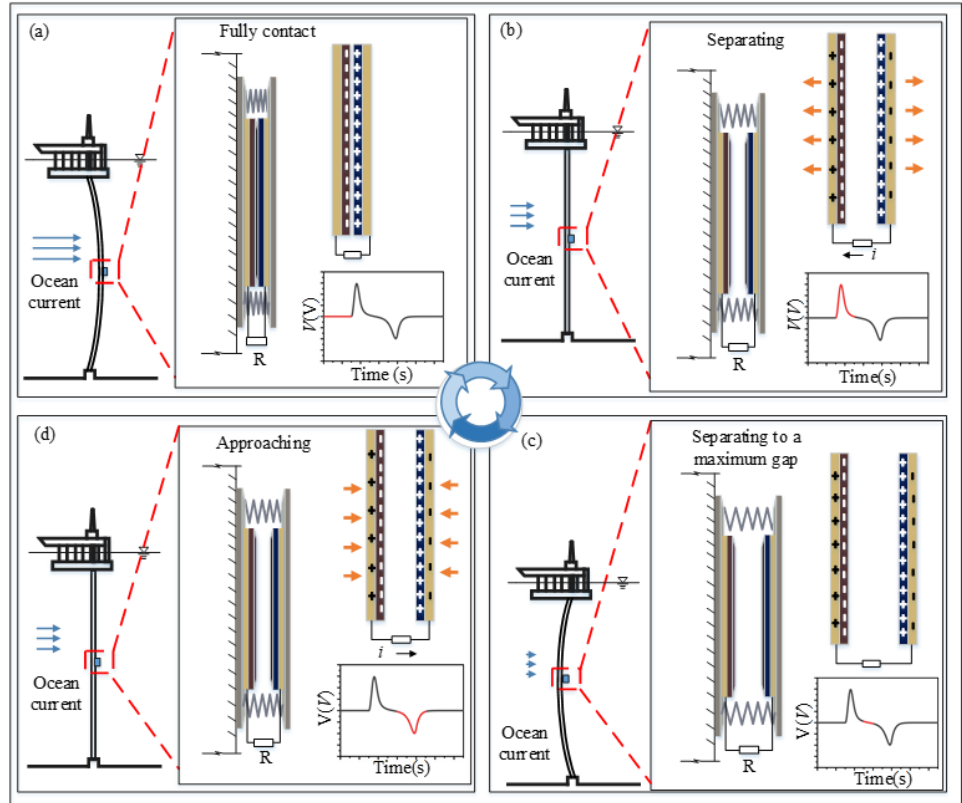
Figure 2. Four process steps for a TENG device to convert the mechanical energy of a vibrating pipe into electricity. ( a ) In the fully contact process, the pipe is bended under the current excitation, and the tribo-pair are getting into contact; ( b ) In the separating process, the current excitation is reduced, and the pipe reverts back and the tribo-pair starts to separate; ( c ) In the separating to a maximal gap process, the current excitation keeps reducing, and the pipe keeps bending in the opposite direction due to inertia and the tribo-pair gets separated to the maximum distance; ( d ) In the approaching process, the current excitation increases, and the pipe returns to its original state and the dielectric material films of the tribo-pair begins to approach.